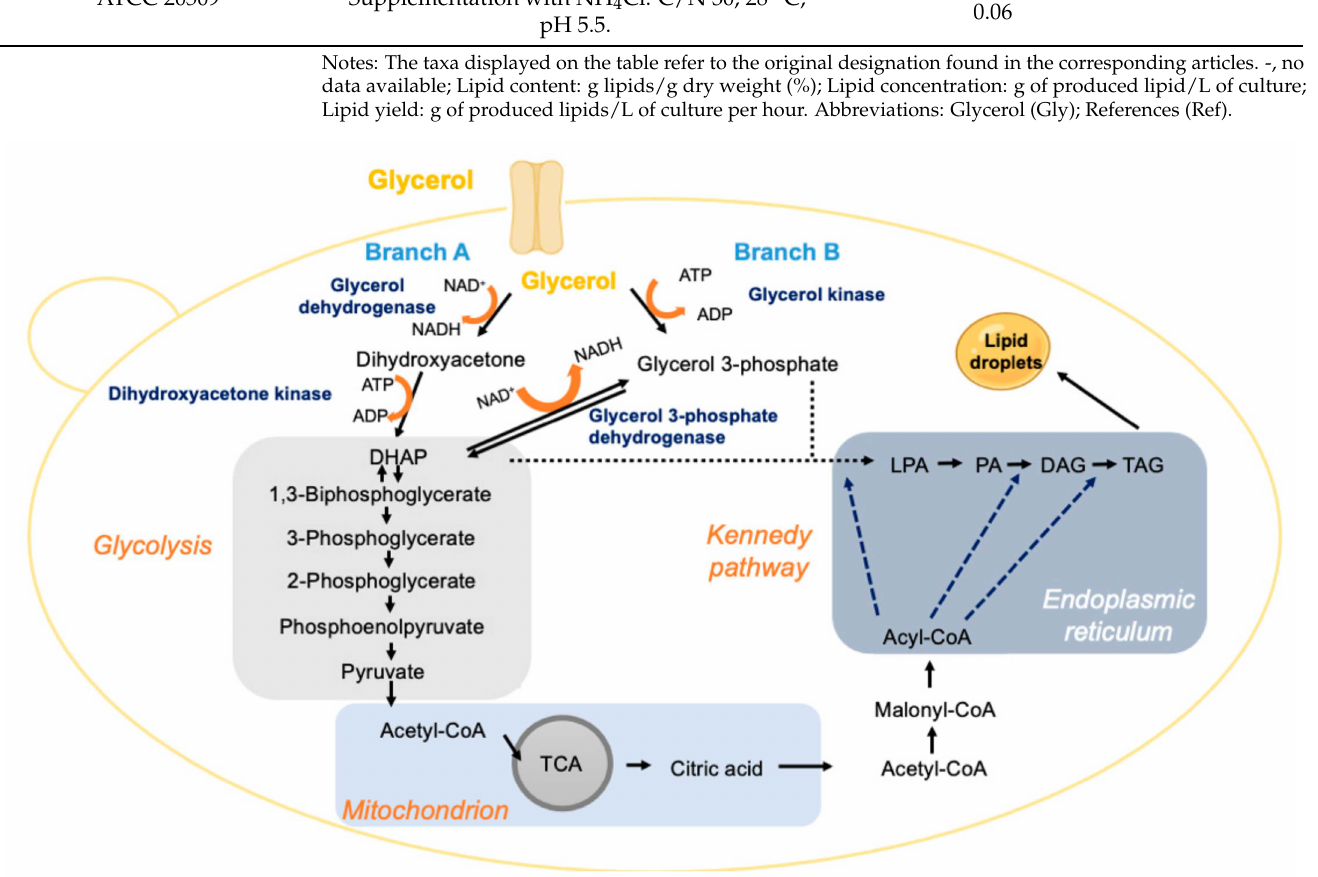
Figure 4. Metabolic pathways involved in glycerol catabolisation for the production of lipids. Abbrevia- tions: ADP, adenosine diphosphate; ATP, adenosine triphosphate; DAG, diacylglycerol; LPA, lysophospha- tidic acid; NAD, nicotinamide adenine dinucleotide; PA, phosphatidic acid: TAG,